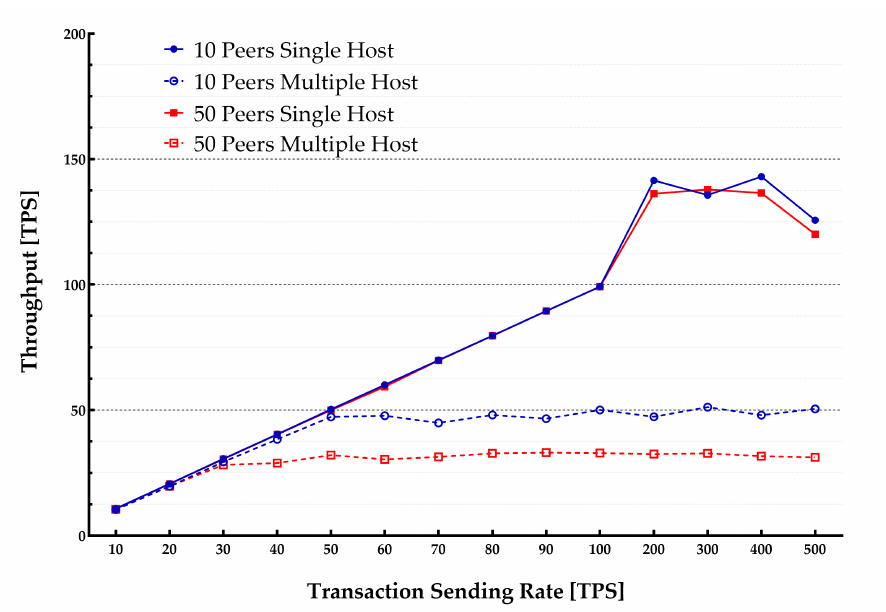
Figure 9. Transactions sending rate vs throughput for various endorsement policies.